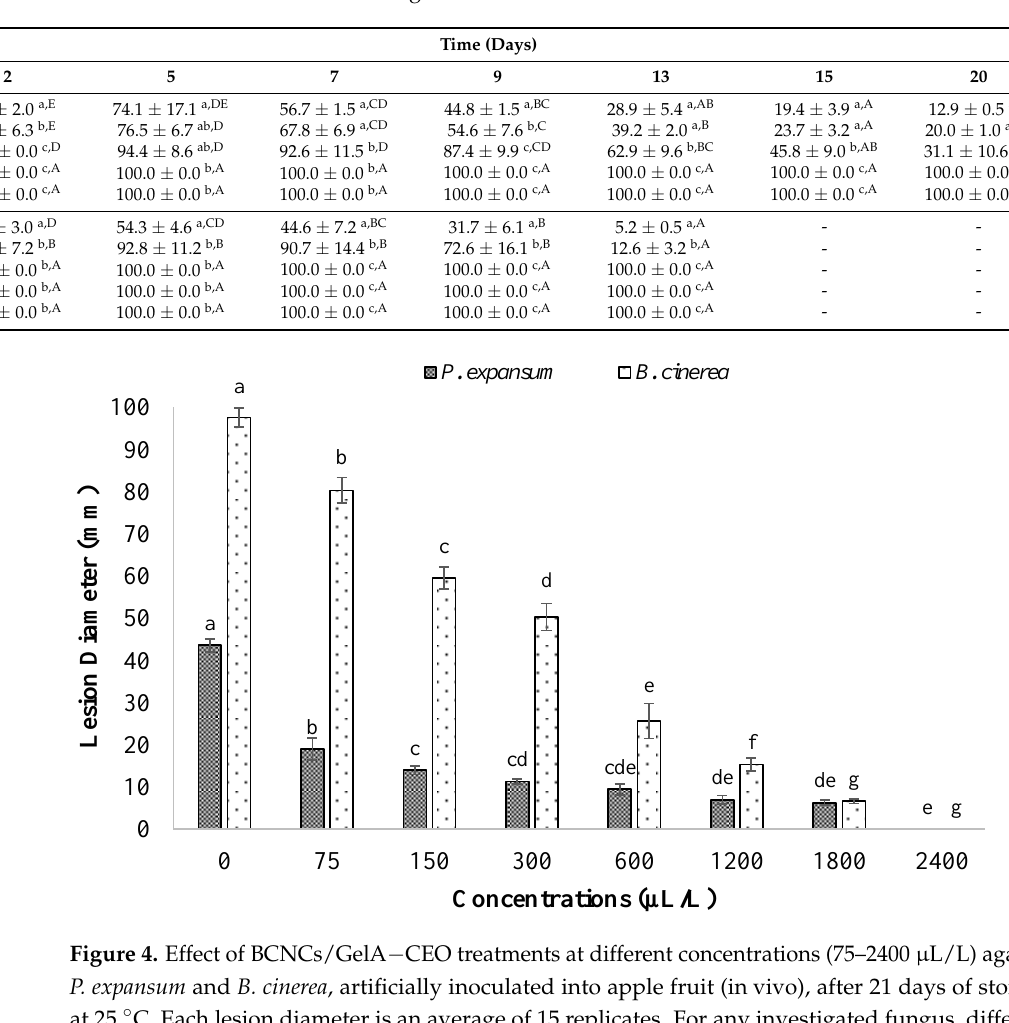
Table 2. Antifungal index (AI,%) of BCNCs/GelA emulsion treatments (CEO concentration = 75–1200 µ L/L) against P. expansum and B. cinerea (in vitro assay). For any in- vestigated fungus, different lowercase letters within the same column denote significant differences ( p < 0.05) among AI values due to the effect of employed CEO concentration, whereas different uppercase letters within the same row express significant differences ( p < 0.05) amongst AI values due to the effect of observation time. Legend: - = not measured.